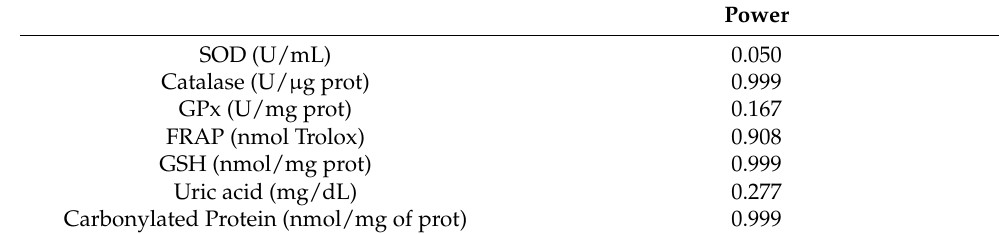
Table 4. Statistical power of